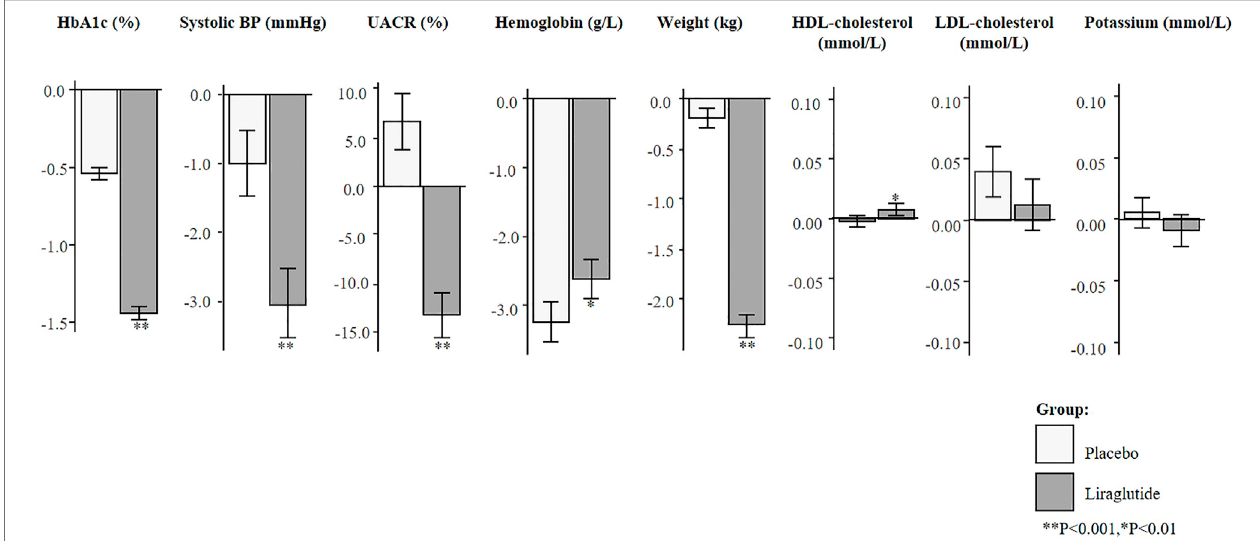
FIGURE 1 | Mean changes in risk markers from baseline to 6-months (or fi rst follow-up) measurement in the imputed total population of the LEADER trial (N = 9,340).Changesarepresented asmeanwith95%con fi dence intervals,fortheplaceboandliraglutidegroup. HbA1c,glycated hemoglobin; BP,blood pressure;UACR, urinary-albumin-creatinine-ratio; HDL, high-density-lipoprotein; LDL, low-density-lipoprotein.